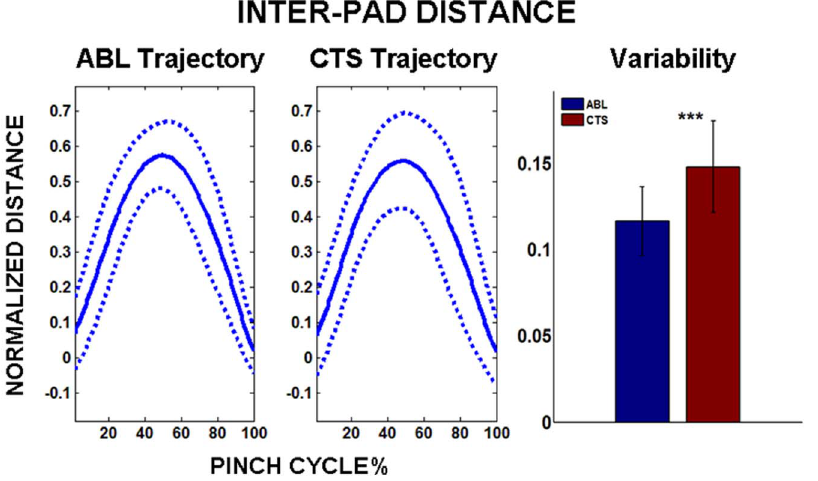
Figure 3. Inter-pad distance. LEFT: Inter-pad trajectory over pinch cycle for ABL and CTS subject groups. Solid line denotes mean trajectory, and dotted line denotes variability ( 6 1 s.d.) about mean trajectory. RIGHT: Comparing variability between ABL and CTS groups. Note: ***p , 0.001, Distances self-normalized by subject ‘‘palm width’’.